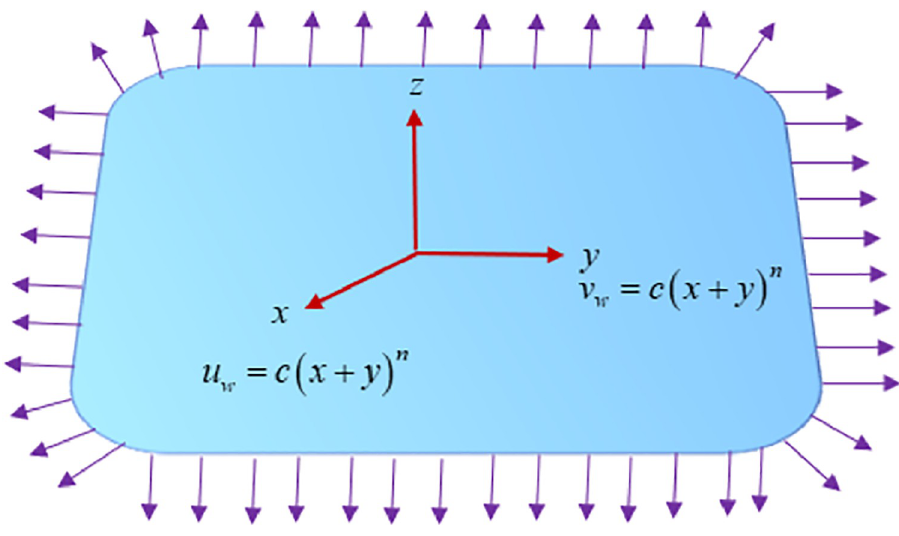
Fig 1. Geometry of the